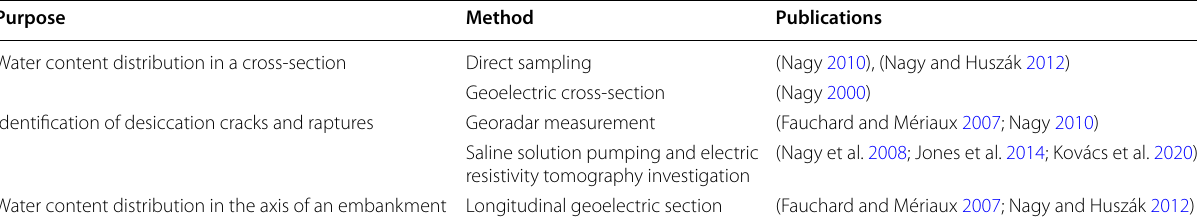
Table 2 Application of geotechnical sampling and geophysical